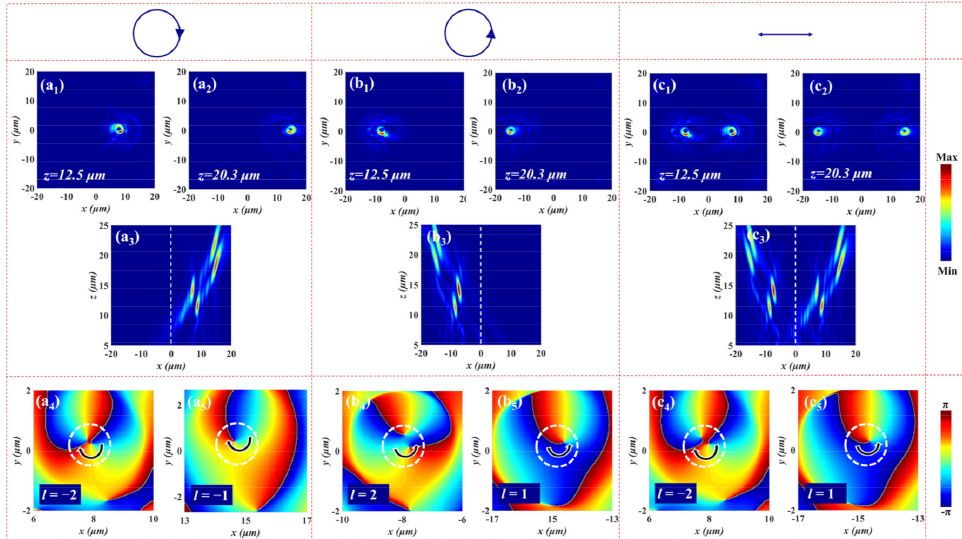
Figure 5. The simulated electric field intensity distributions of FOVs at the focal plane for ( a 1 , a 2 ) LCP, ( b 1 , b 2 ) RCP, and ( c 1 , c 2 ) XLP illumination. The electric field intensity profiles of FOVs in the x-z plane upon the illumination with ( a 3 ) LCP, ( b 3 ) RCP, and ( c 3 ) XLP input light. The corresponding phase distributions at the focal plane in the x - y plane under ( a 4 , a 5 ) LCP, ( b 4 , b 5 ) RCP, and ( c 4 , c 5 ) XLP incident